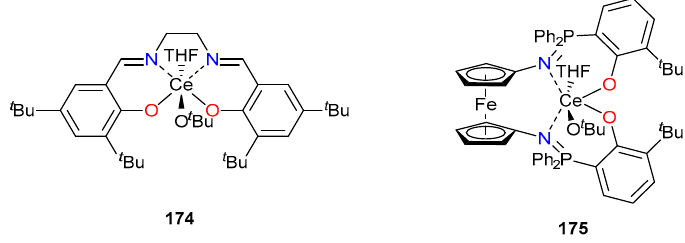
Figure 31. Redox switchable Ce-based catalysts [91].